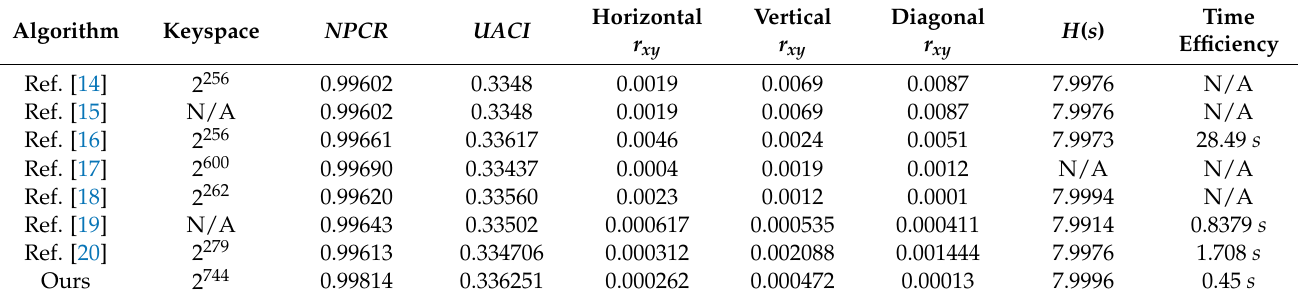
Table 1. Comparison metrics of our cryptosystem with similar works in the topic